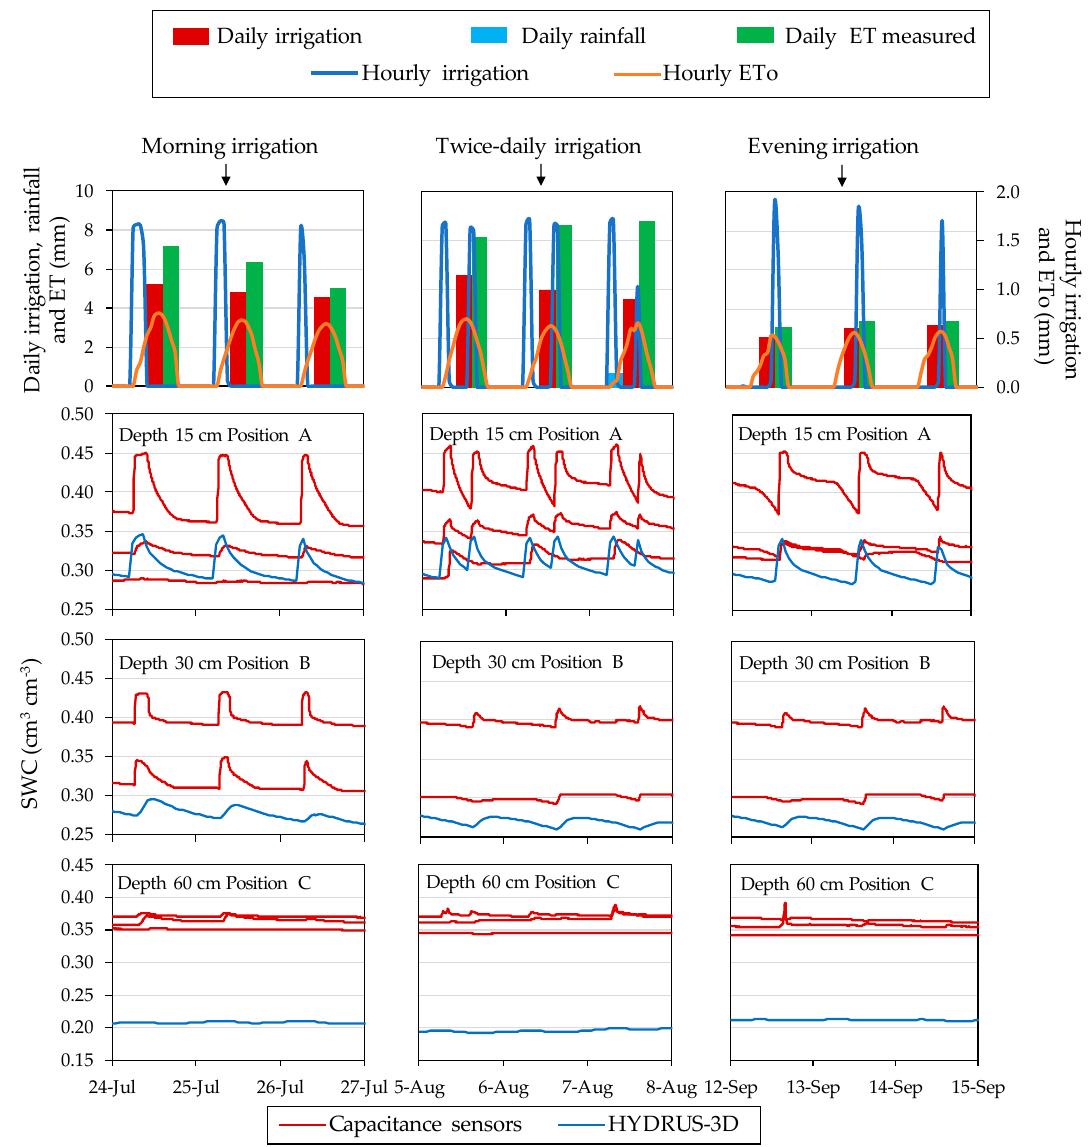
Figure 9. Relationship between the daily shape of the SWC curve and the moment of the day of irrigation in Plot II in 2017. In red are represented sensor moisture repetitions and in blue is represented the model.